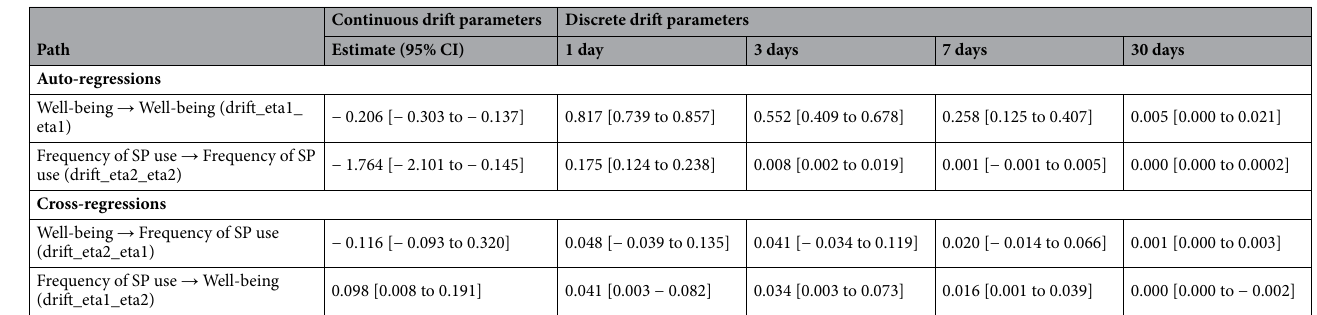
Table 1. Continuous and discrete parameter estimates of well-being and frequency of smartphone use. SP smartphone. All effects not including the value of zero in the 95% CI interval were significant at the 0.05 level. Continuous drift parameters include continuous (i.e., time-independent) autoregressive and cross-lagged estimates in the drift matrix, Discrete drift parameters report the discrete (i.e., time-dependent) standardized effects at intervals of 1 day, 3 days, 7 days, and 30